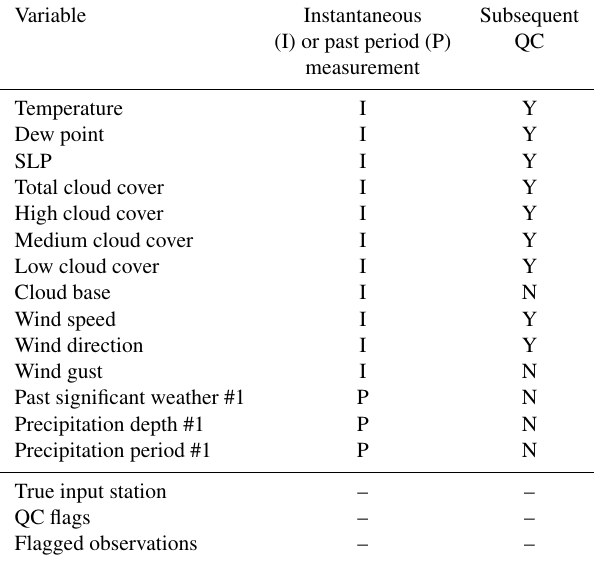
Table 4. Variables present within the NetCDF files in HadISD.2.0.0. The second column indicates whether the value is an instantaneous measure or a time-averaged quantity. The third column shows the subset that we quality